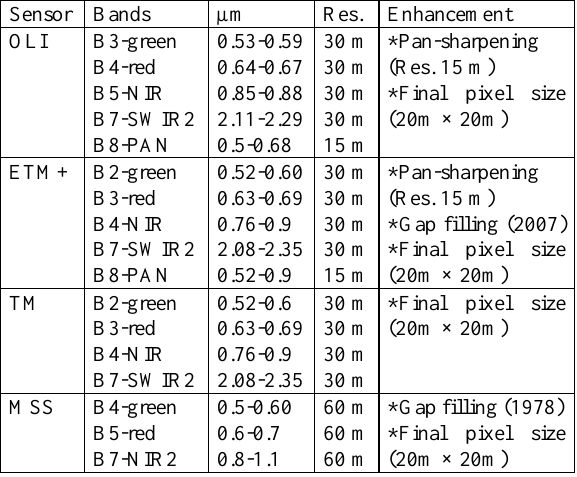
Table 2 . Details of spectral Landsat bands used, and the pre- processing procedures conducted in the current